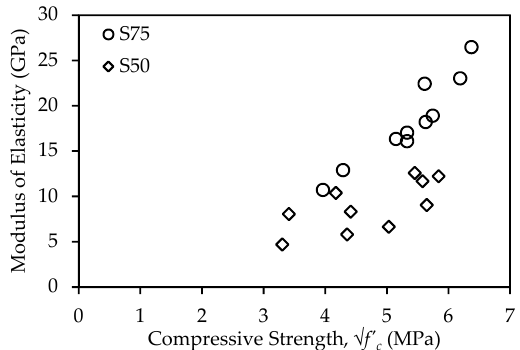
Figure 13. Relationship between modulus of elasticity and cylinder compressive strength.